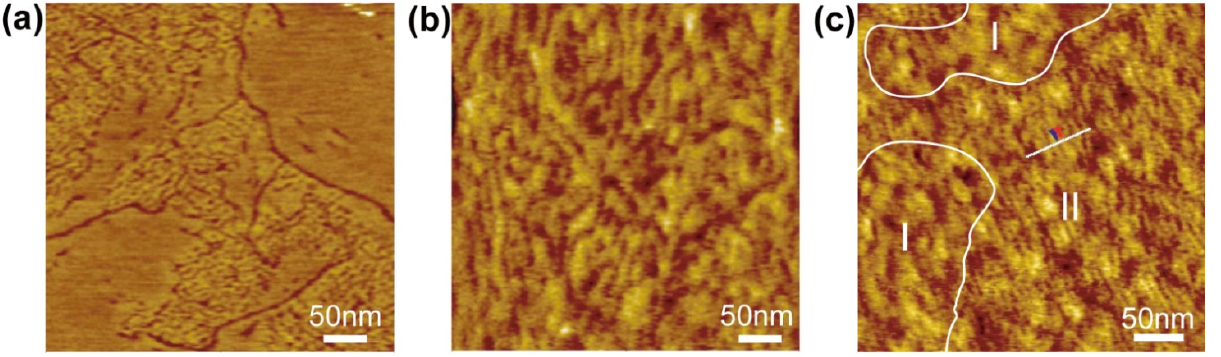
Figure 5. DPPC-SLB including gA ( a ) on mica, ( b ) on chemically oxidized SiO tethered on avidin-modified SiO /Si. The concentration of gA is 2 mol% in ( a ), ( b ), and 1 2 mol% in ( c ). Reprinted from [130] with modification with permission from